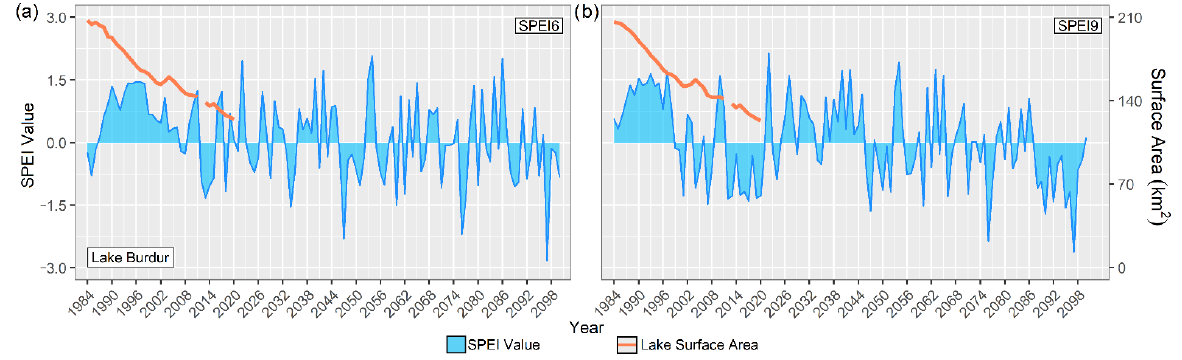
Figure 9. Lake Burdur in 1985 ( a ) and in 2020 ( b ) and the volume of water change in the lake from 1970 to 2080 ( c ).